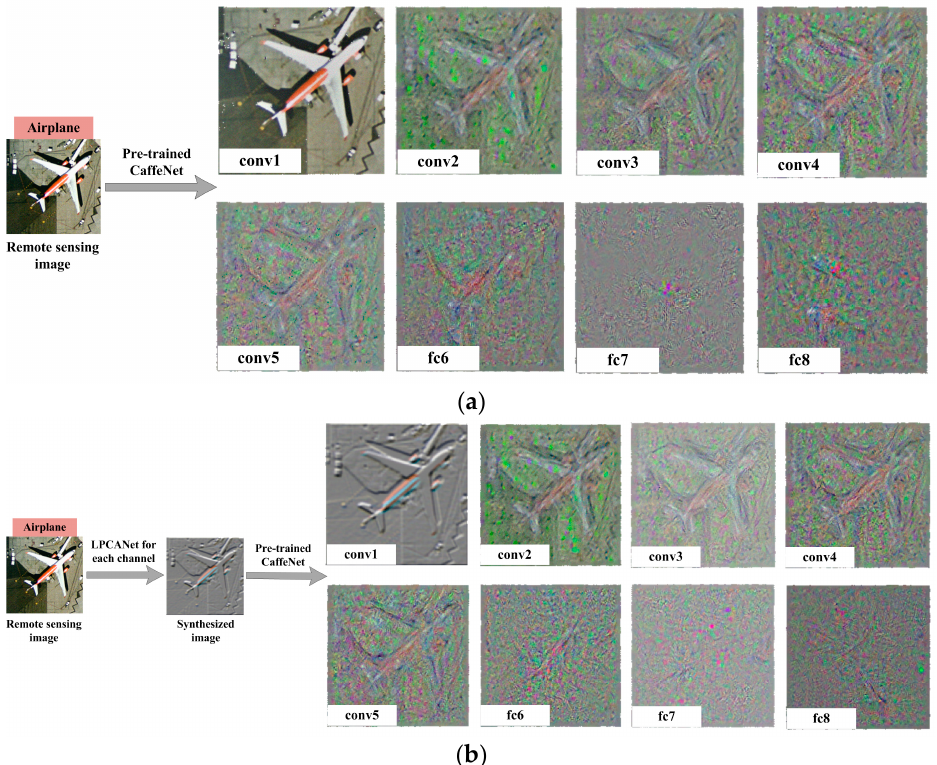
Figure 12. Reconstruction of deep CNN activations from different layers of CaffeNet in condition of: ( a ) Off-the shelf; and ( b ) Architecture (I). The method presented in [39] is used for visualization.